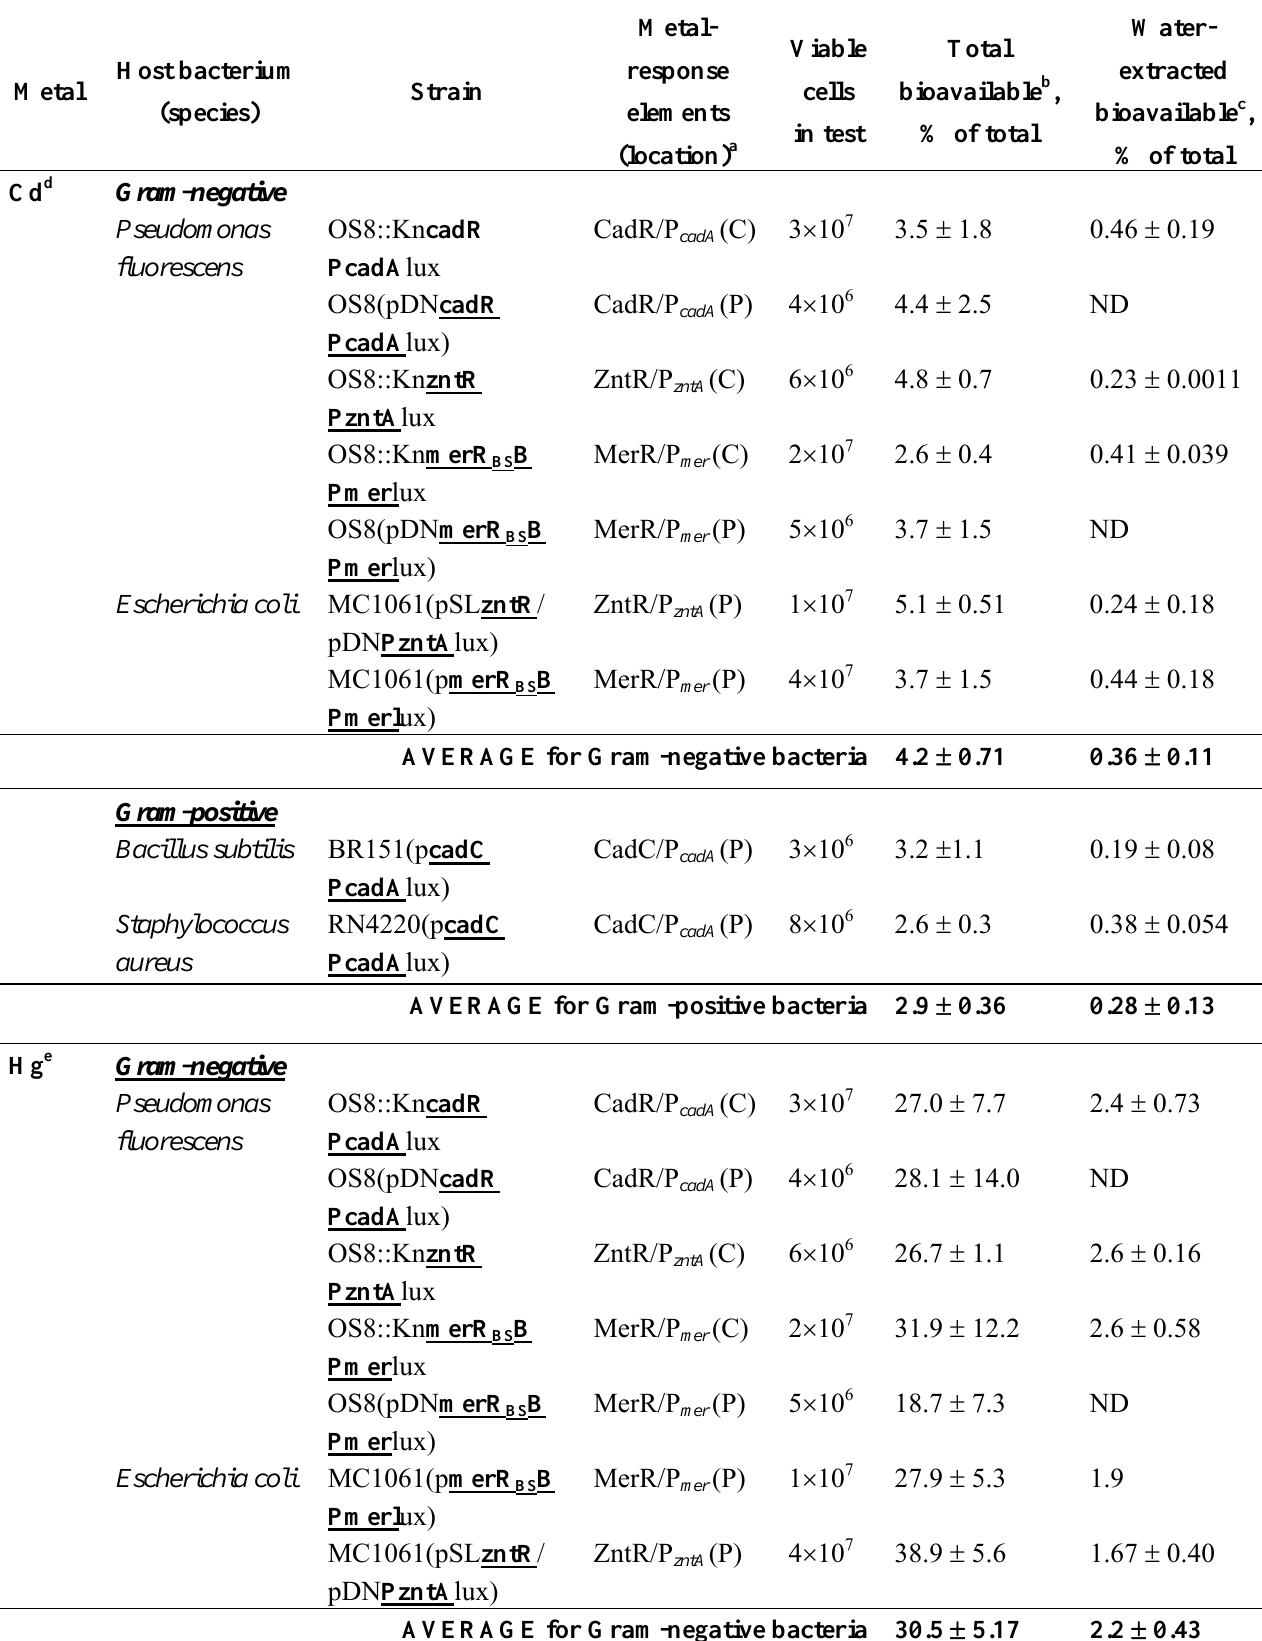
Table 2. Bioavailability of Cd, Hg and Zn in soil to different sensor strains. Data represent mean  standard deviation of three independent